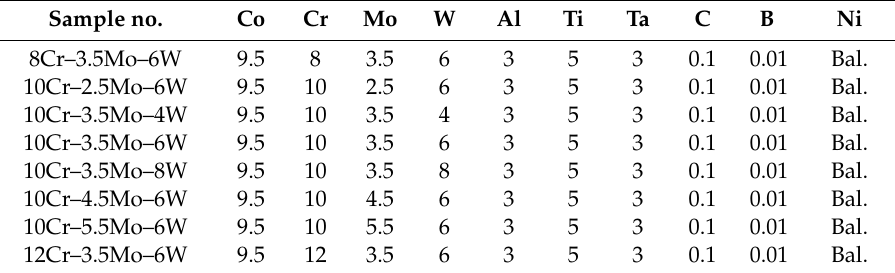
Table 1. Nominal composition of alloys used in this